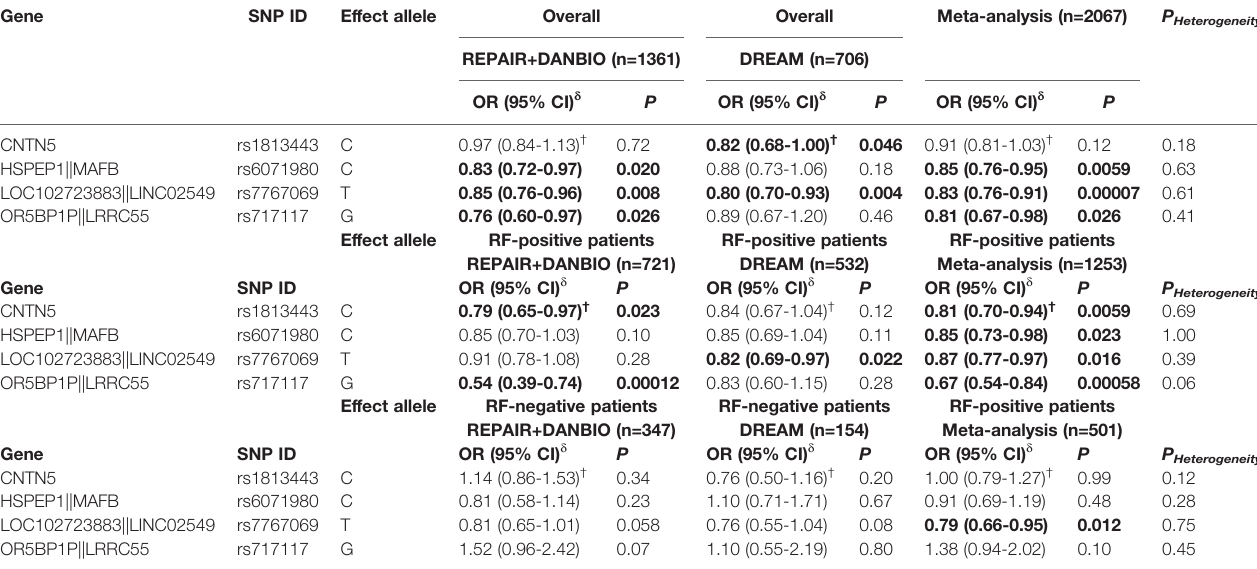
TABLE 4 | Overall and RF-speci fi c meta-analysis of the CNTN5 rs1813443 , MAFB rs607198 , LINCO2549 rs7767069 and LRRC55 rs717117 polymorphisms and response to anti- TNF drugs.